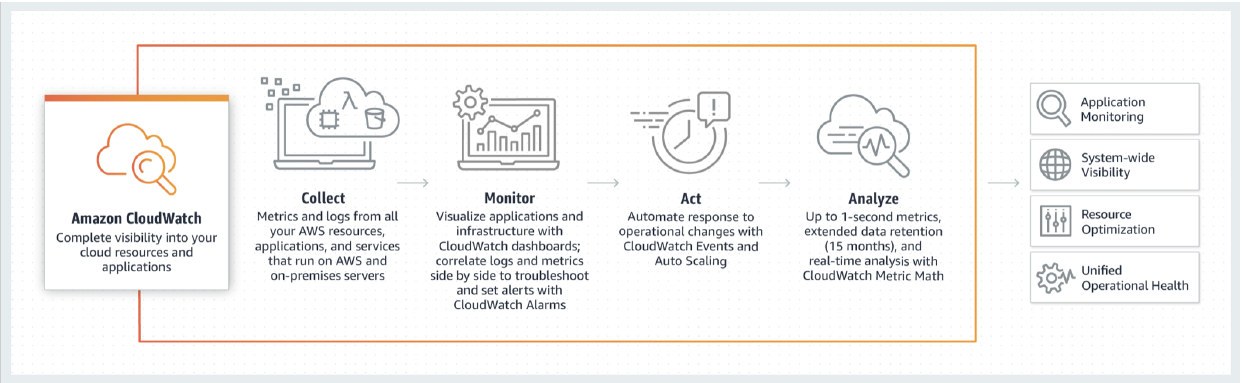
Figure 9. AWS CloudWatch.